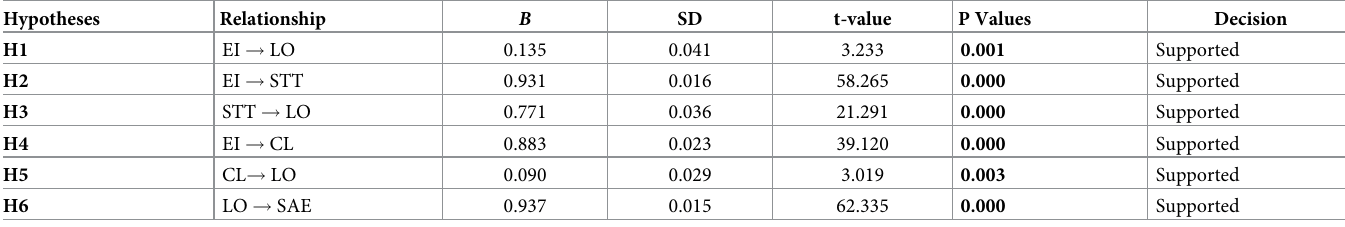
Table 6. Results of structural model path coefficient (direct